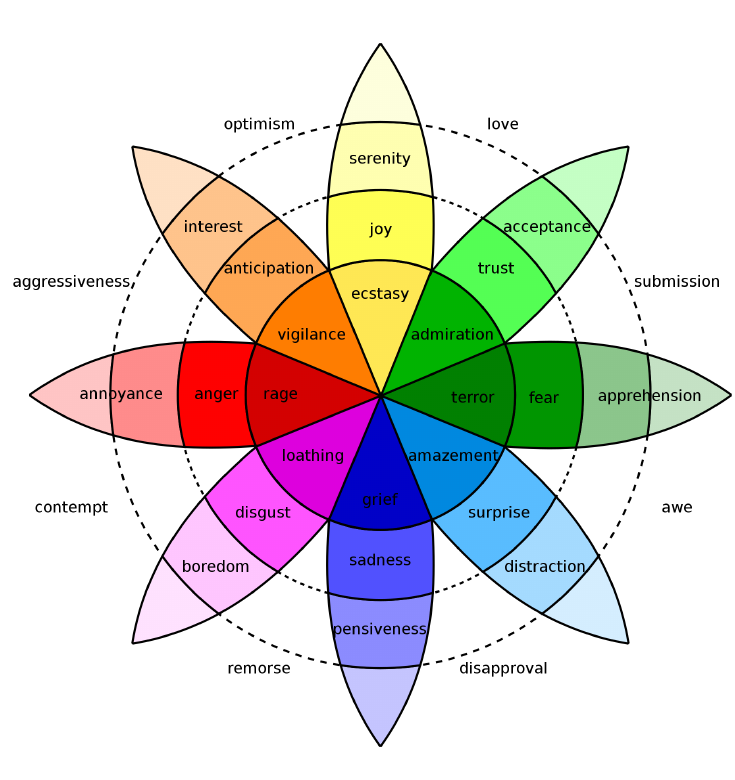
Figure 1. Plutchik’s wheel of